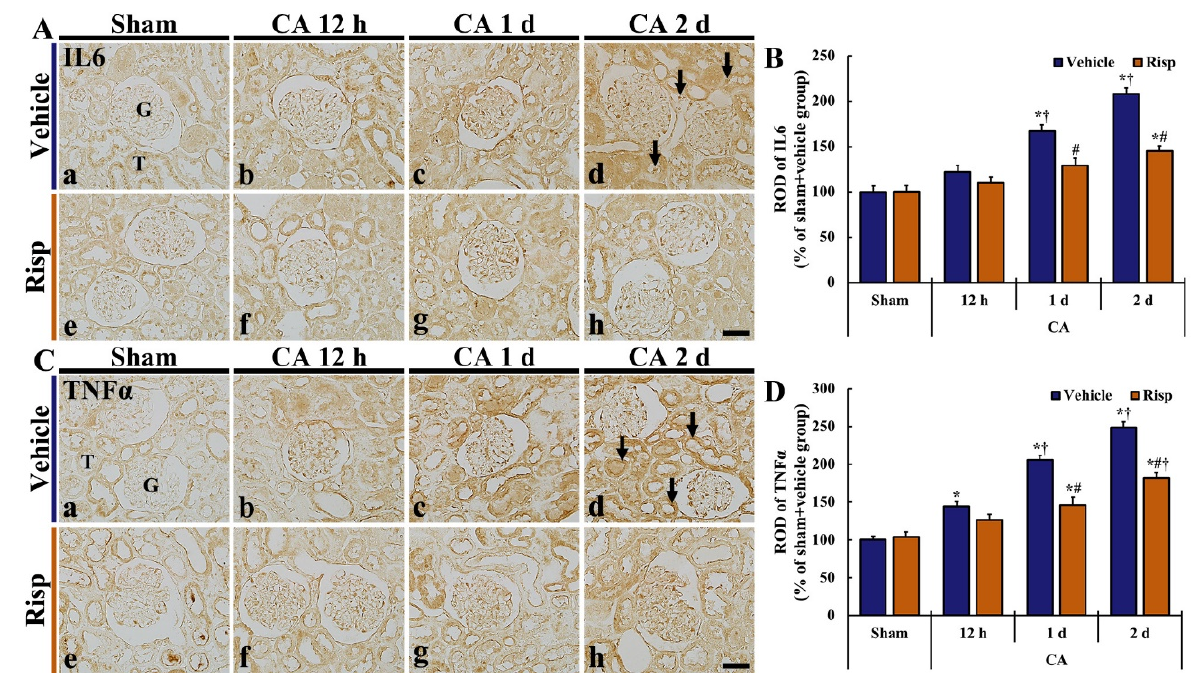
Figure 5. ( A , C ) Immunohistochemical staining of IL6 ( A ) and TNFα ( C ) in the kidney of the Sham-vehicle ( a ), CA-vehicle ( b – d ), Sham-Risp ( e ), and CA-Risp ( f – h ) groups at 12 h, one day, and two days after CA/CPR. IL6 and TNFα immunoreactivities in the CA-vehicle group are gradually and significantly enhanced after CA/CPR: On day 2 after CA/ROSC, strong IL6 and TNFα immunoreactivities are found in tubular cells (arrows). However, in the CA-Risp group, IL6 and TNFα immunoreactivities are significantly lower than those shown in the CA-vehicle group. G, glomerulus; T, tubule. Scale bar = 100 μm. ( B , D ) RODs of IL6 ( B ) and TNFα ( D ) immunoreactivities. The bars indicate the means ± SEM ( n = 7, respectively; * p < 0.05 vs. Sham-vehicle group; # p < 0.05 vs. CA-vehicle group; † p < 0.05 vs. Pre-time point of corresponding group).